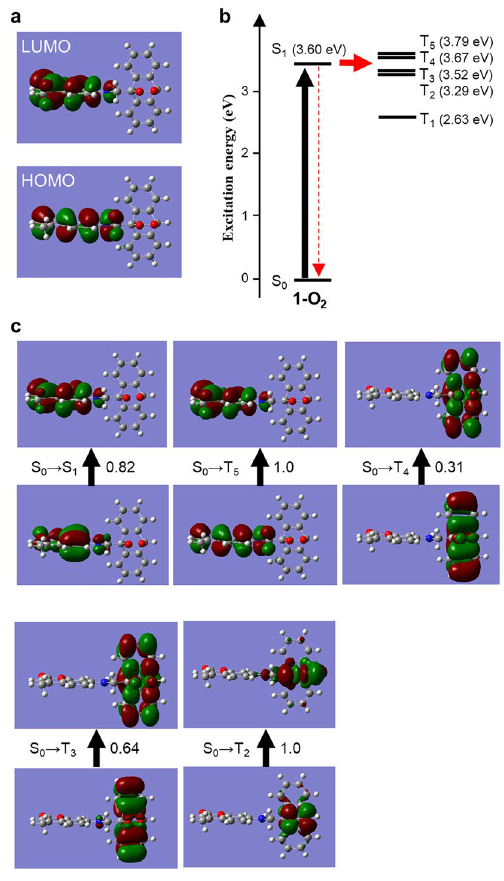
Figure 3. DFT calculations on 1-O 2 at the UB3LYP/6–311 ++G** level of theory with self-consistent reaction field (SCRF) where DMF is the solvent. ( a ) HOMO and LUMO. ( b ) Energy diagrams of the calculated excited states. ( c ) Natural transition orbitals (NTOs) of the most probable transitions. Black arrows indicate the direction of the transition. The accompanied values indicate the coefficients that correlate with the transition probability, where 1 and 0 are the most and worst